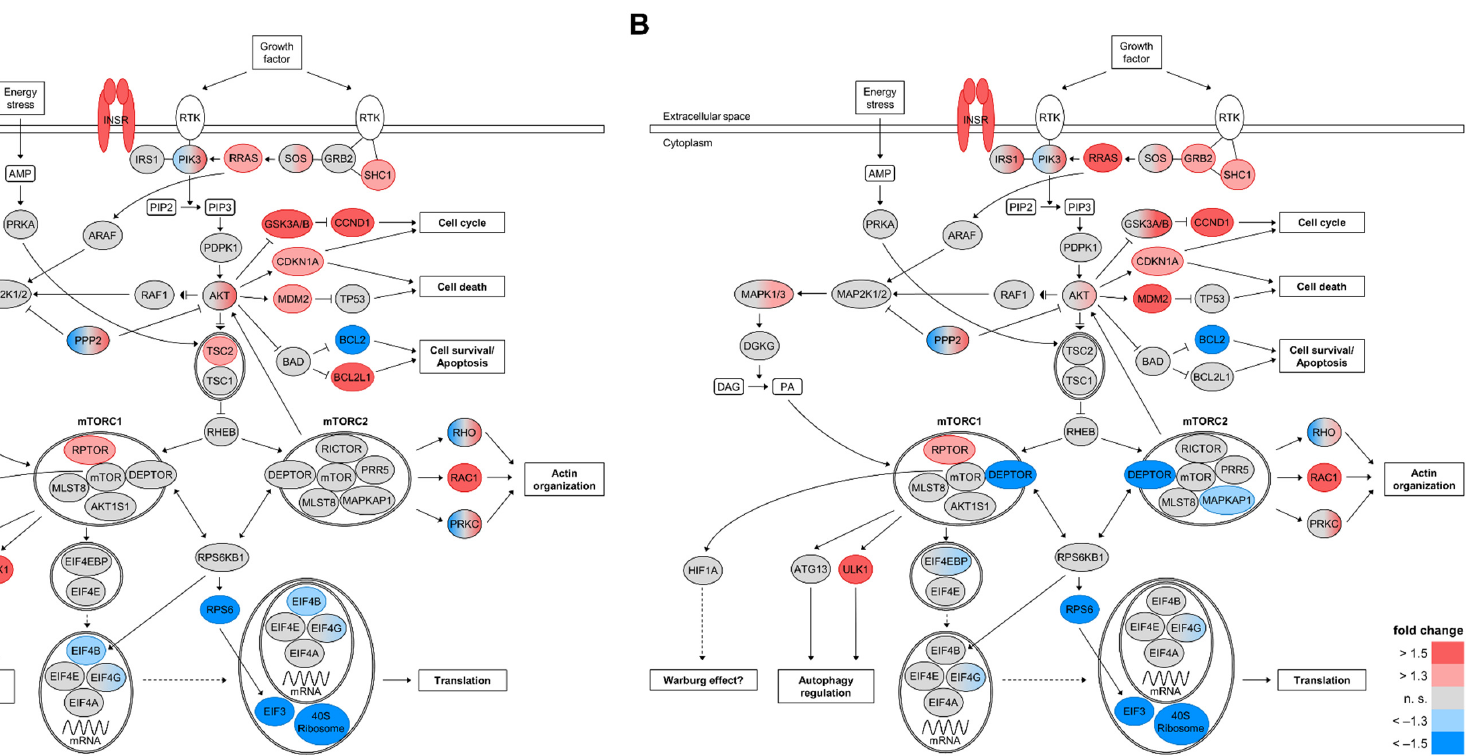
Figure 5. Alterations in the expression of genes involved in AKT/mTOR signaling. The transcript levels were identified by microarray analyses as a result of either Ren(1a–9) or Ren(2–9) overexpression as compared with pIRES H9C2 control cells. The red color indicates genes with increased mRNA levels and the blue color indicates those with decreased mRNA levels as compared with pIRES controls, while the white color indicates not significantly altered genes with q > 0.05. Shown are only significantly altered genes ( q < 0.05) that exhibit a fold change of ≥ |1.3| in at least one group comparison.